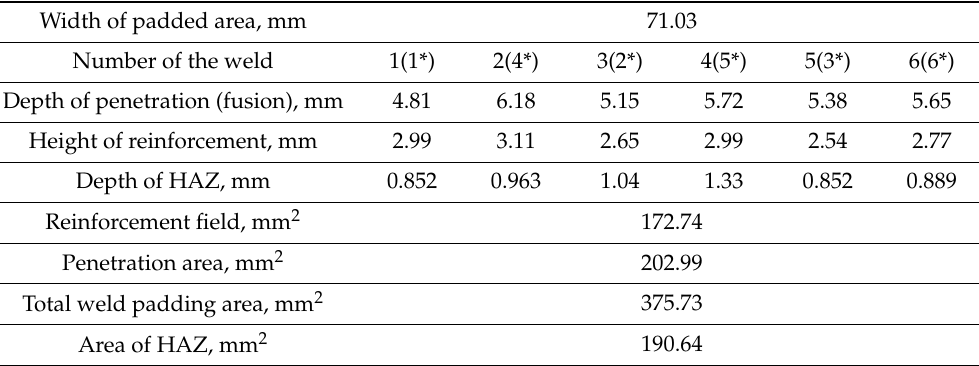
Table 3. The geometrical characteristics of the deposition zone in plate